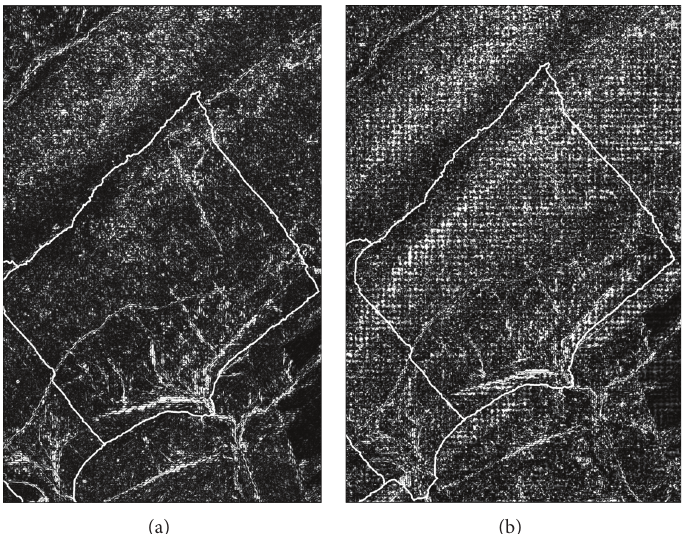
Figure 10: Difference between splined surface and original DEM for CZO LiDAR (a) and PAMAP LiDAR (b). White areas correspond to high roughness values.